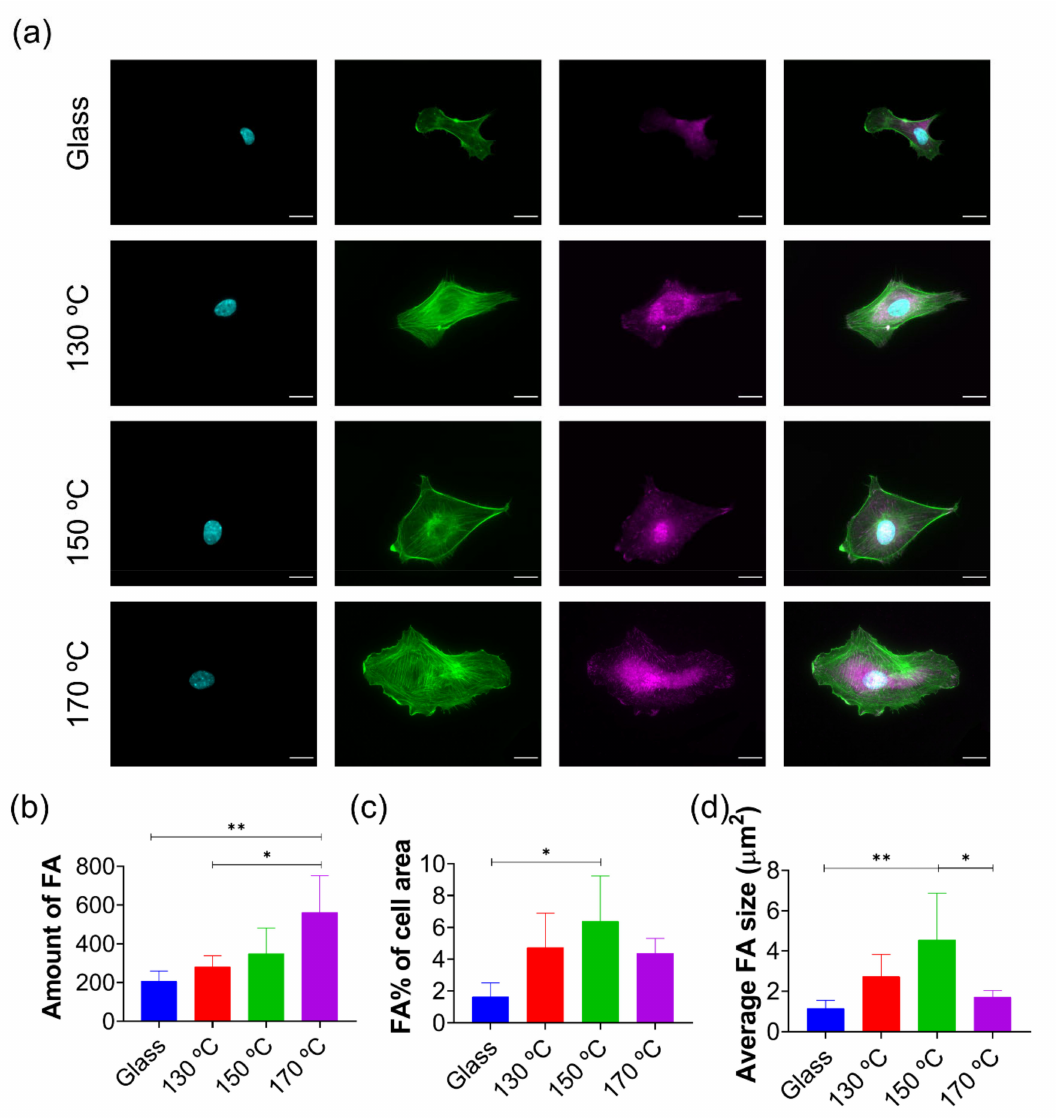
Figure 3. HUVECs FA quantification on PGS substrates. ( a ) Immunofluorescence images of HUVEC nuclei (cyan), actin cytoskeleton (green) and vinculin (magenta) as a focal adhesion (FA) marker of cells cultured after 3 h on glass and different PGS cured materials. Quantification of ( b ) the amount, ( c ) area and ( d ) average size of FA. FA area was calculated as the percentage of the total cell area. All immunofluorescence images share the same scale bar (20 µ m). Sample data distributions were analysed through a one-way ANOVA and Bonferroni post hoc multiple mean comparison test, with a p -value < 0.05. *, p < 0.05 and ** p <